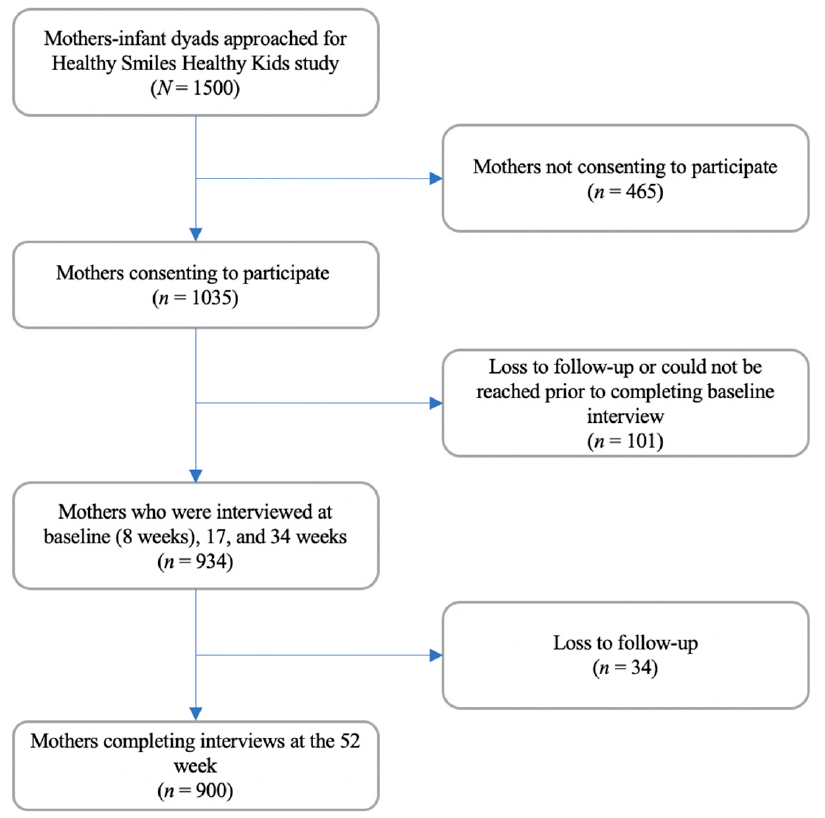
Figure 1. Flowchart of study sample recruitment and retention.